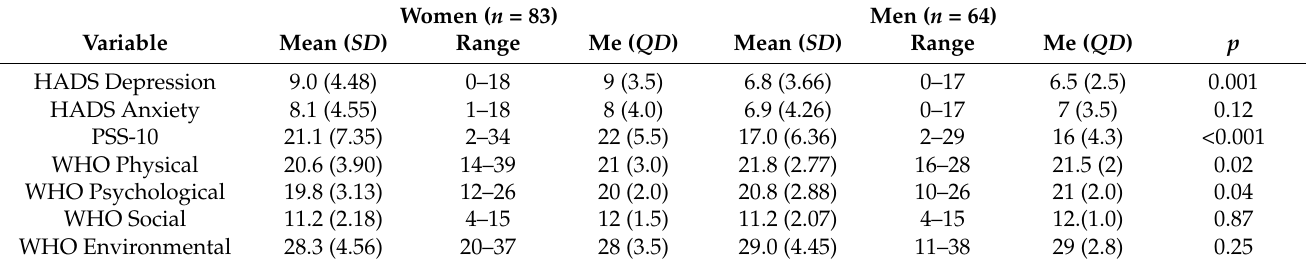
Table 3. Gender differences in perceived levels of depression, anxiety, stress, and quality of life. Women ( n = 83) Men ( n =